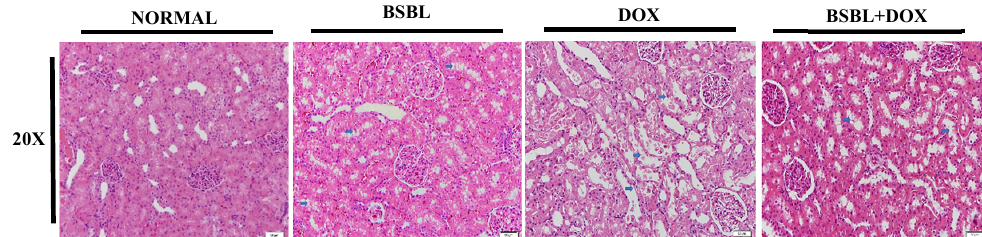
Figure 4. Histopathology of the kidney. Normal control and α - Bisabolol alone treated rat’s kidney showed no pathological changes. DOX-alone treated rats showed thinning and loss of apical cytoplasm, necrosis of individual tubular epithelial cells, loss of nuclei, adhesion, and denudation of tubular basement membrane, whereas α -Bisabolol treatment reinstates the near normal renal architecture in DOX-injected rats (Magnification; 20 × ).